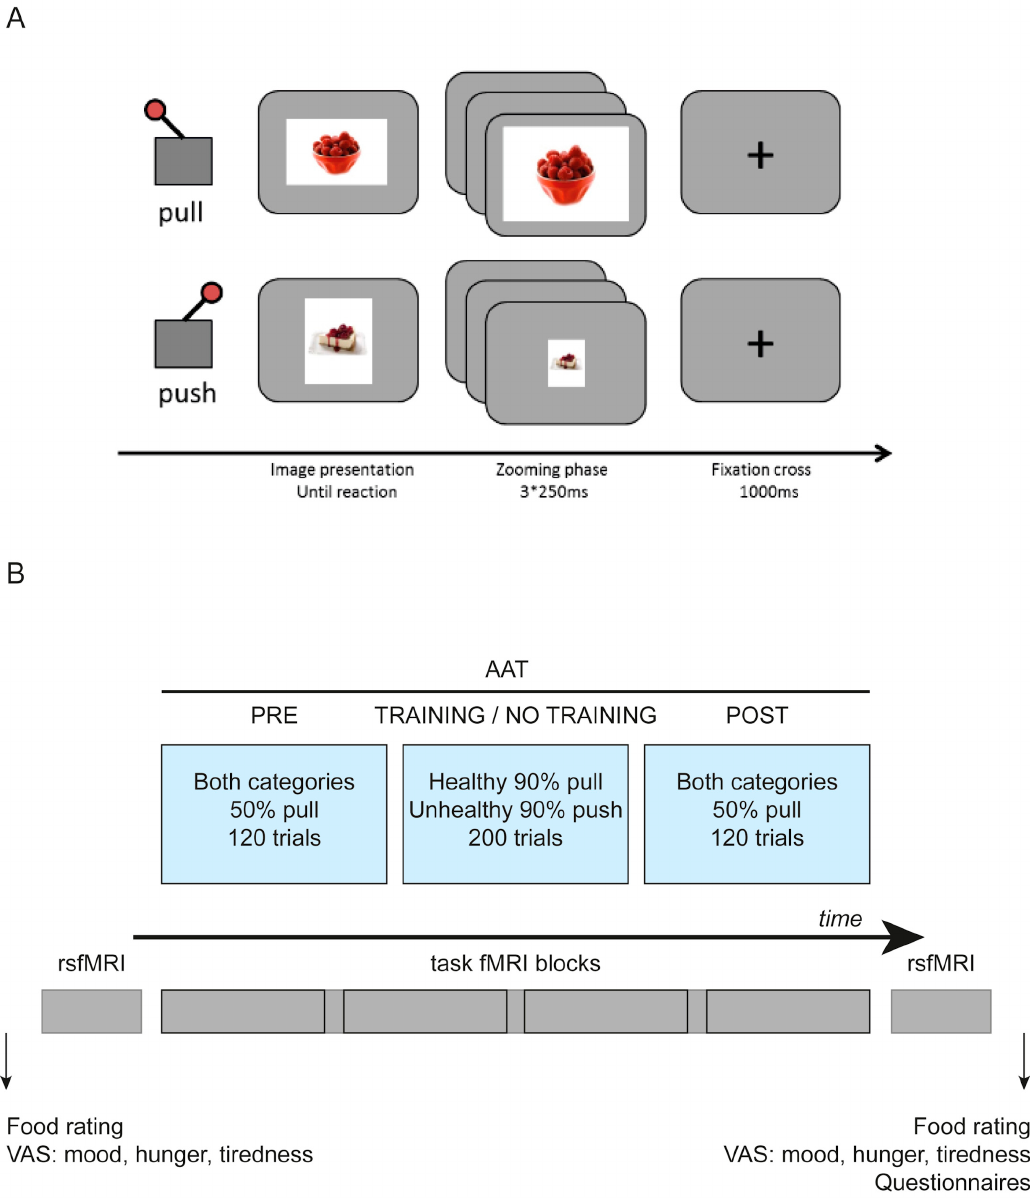
Figure 1. ( A ): Modified approach–avoidance task. ( B ): Overview of the experimental paradigm. AAT: approach–avoidance task, rsfMRI: resting-state functional magnetic resonance imaging.